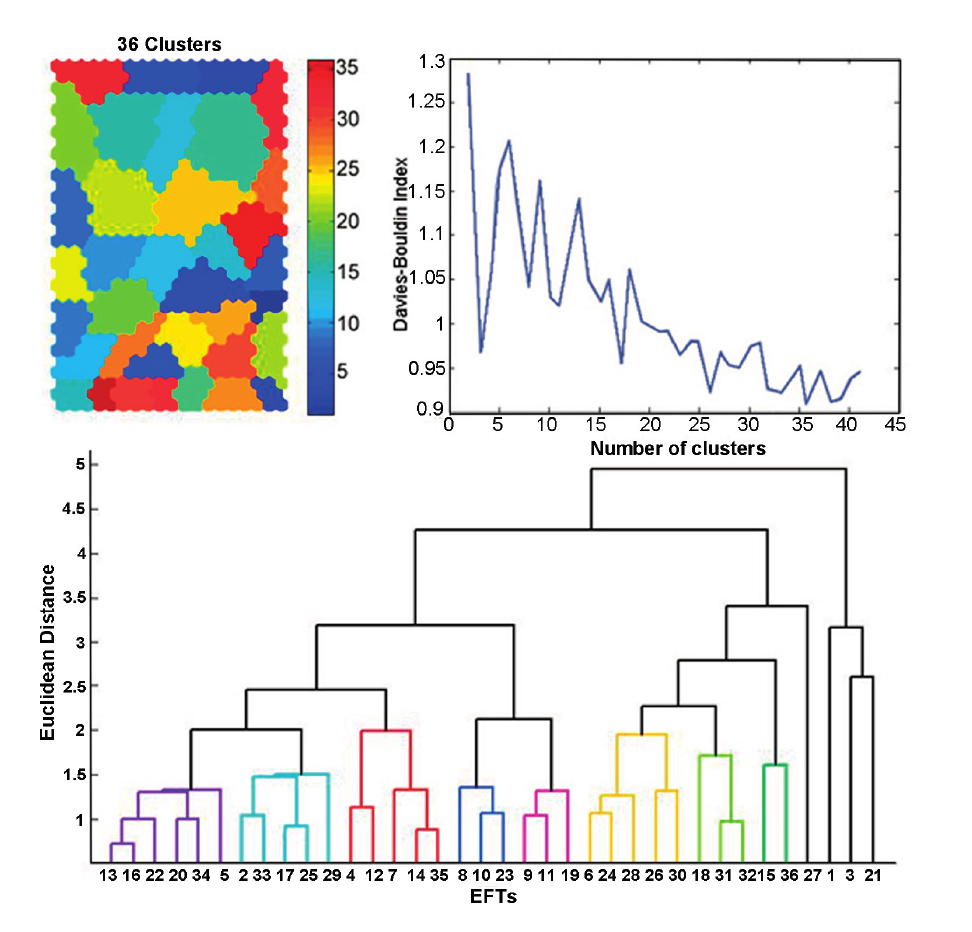
Figure 7. ( Left-Upper ) Clusters obtained with the modified k-means , ( Right-Upper ) validity index values for Davies-Bouldin as a function of the number of clusters ranging from 2 to 36 and ( Down ) similarity among the dendrogram resulting from hierarchical agglomerative cluster